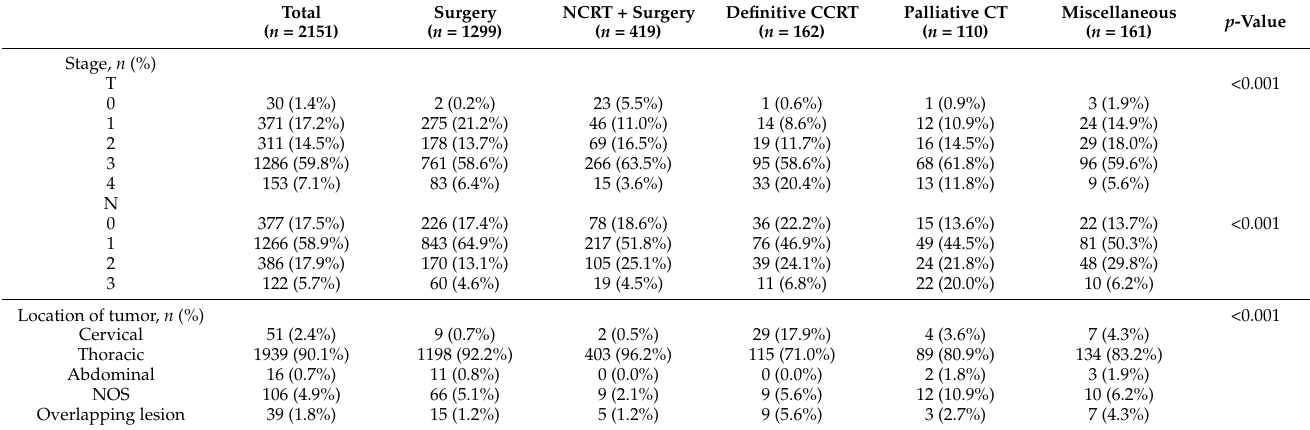
Figure 3. Sankey diagram for visualization of treatment and outcome patterns for 2 years after di- agnosis of patients with locally advanced esophageal cancer. The thickness of the line in the figure shows how many patients belonged to each specific treatment. 3.3. Survival Outcomes From 1994 to 2002, the 5-year OS of patients treated for locally advanced ESCC was 36.8% (95% confidence interval (CI), 31.4–43.1%). From 2003 to 2012, the 5-year OS rate was improved to 42.2% (95% CI, 38.8–45.7%). Notably, after 2013, when the use of NCRT for advanced ESCC became routine, the 5-year OS rate was much improved to 56.3% (95% CI, 53.2–59.6%). Kaplan–Meier survival curves for patients treated according to the period are shown in Figure 4.